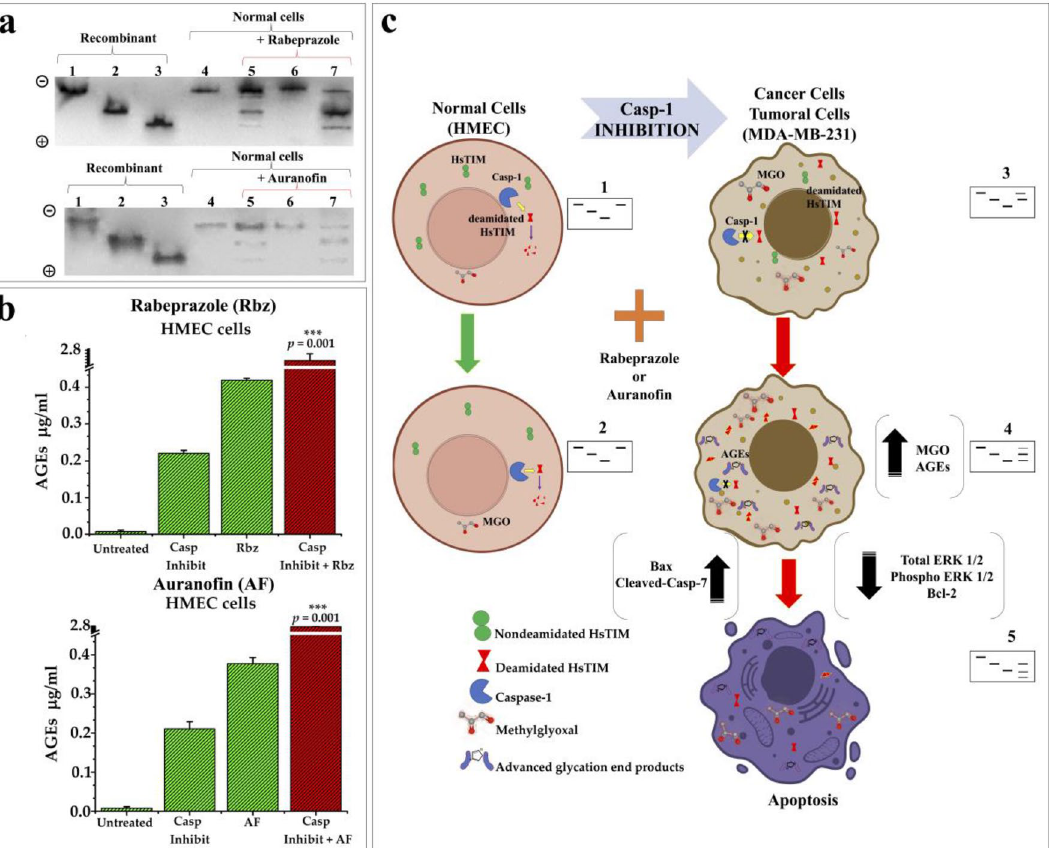
Figure 6. Effects of caspase-1 inhibition and thiol drugs in normal cells. ( a ) nPAGE and western blot analysis of normal cells (HMEC) with or without treatment with a caspase-1 inhibitor and thiol drugs. Lanes 1 to 3 (1 µg protein/lane): recombinant nondeamidated, once deamidated and twice deamidated HsTIM, respectively. Lanes 4 to 7 (100 µg protein/lane): proteins from the cellular extract of HMEC cells. Lanes 4: control cells without caspase-1 inhibitor and drugs treatment; lanes 5: cells incubated with the caspase-1 inhibitor; lanes 6: cells treated only with rabeprazole (top) or auranofin (bottom), lanes 7: cells incubated with the caspase-1 inhibitor and treated with rabeprazole (top) or auranofin (bottom). The polarity of the gels is indicated on the left side. ( b ) Production of AGEs in normal cells exerted by caspase-1 inhibitor and thiol drugs. Graphs show the differences on AGEs levels in normal cells by using caspase inhibitor (Casp Inhibit), rabeprazole (Rbz), or auranofin (AF) and their combined effects (Casp Inhibit + Rbz or + AF). ( c ) Schematic illustration of the possible role of deamidated HsTIM and caspase-1 in normal and cancerous phenotype. 1, 2, 3, 4, and 5 represent the corresponding nPAGE profiles of HsTIM acidic isoforms from each cell phenotype. Full-length blots of “ a ” panel are shown in Suppl. Fig.